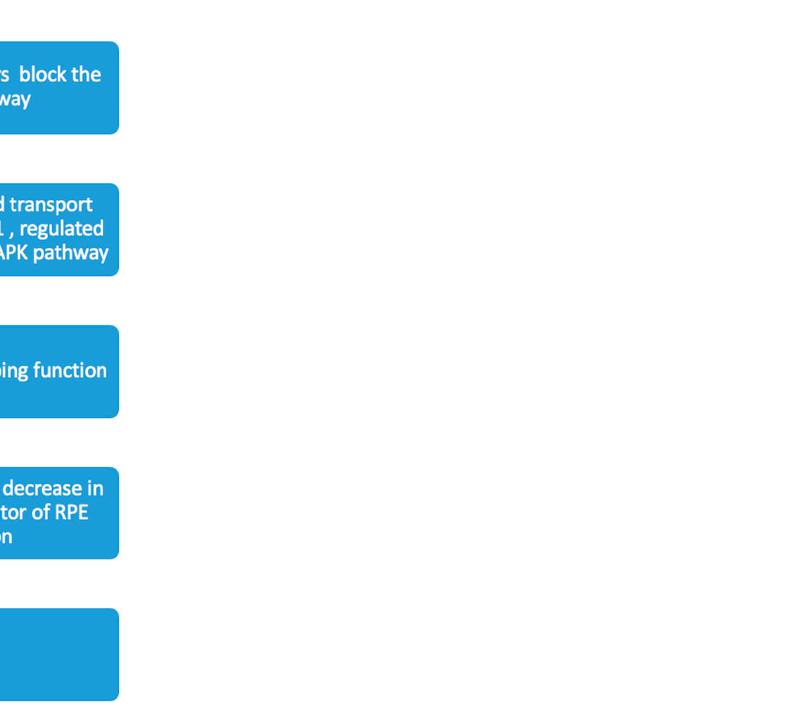
Figure 2. Flow chart of proposed interaction between BRAF/MEK inhibitors and RPE in MEKAR and its possible correlation with Arden ratio decrease. Table 4. SCP and DCP VAD at each control.